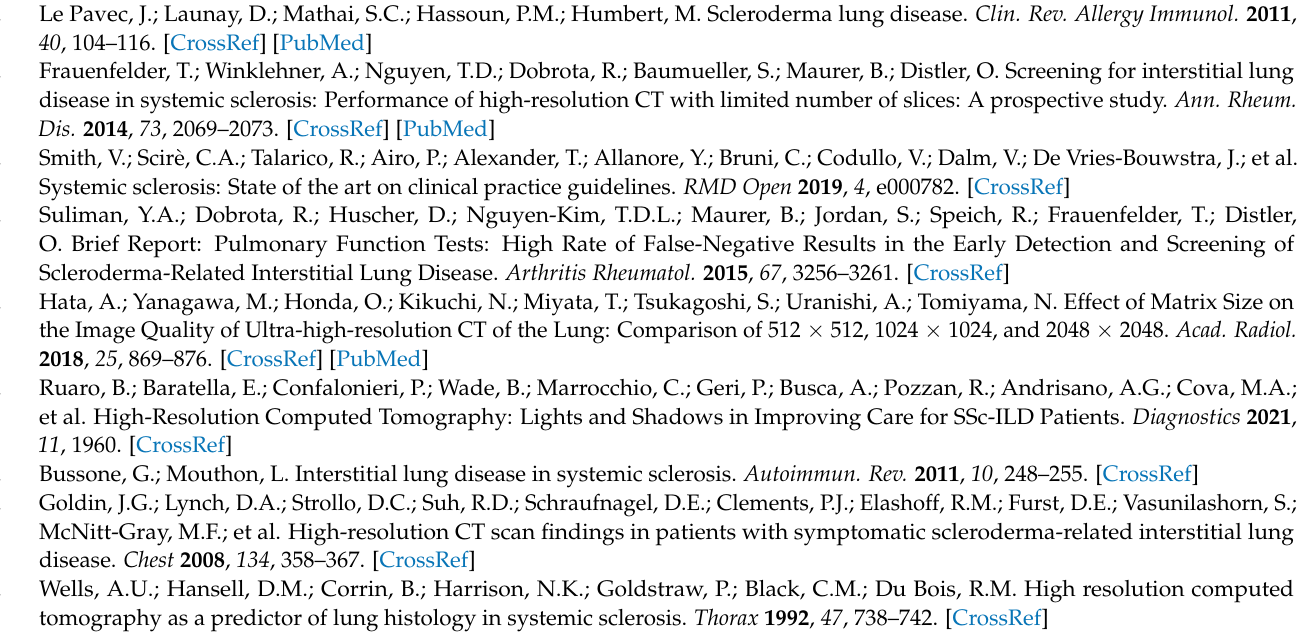
resolution; Figure S10: Extent of ground-glass opacities per matrix resolution; Figure S11: Overall image impression per matrix